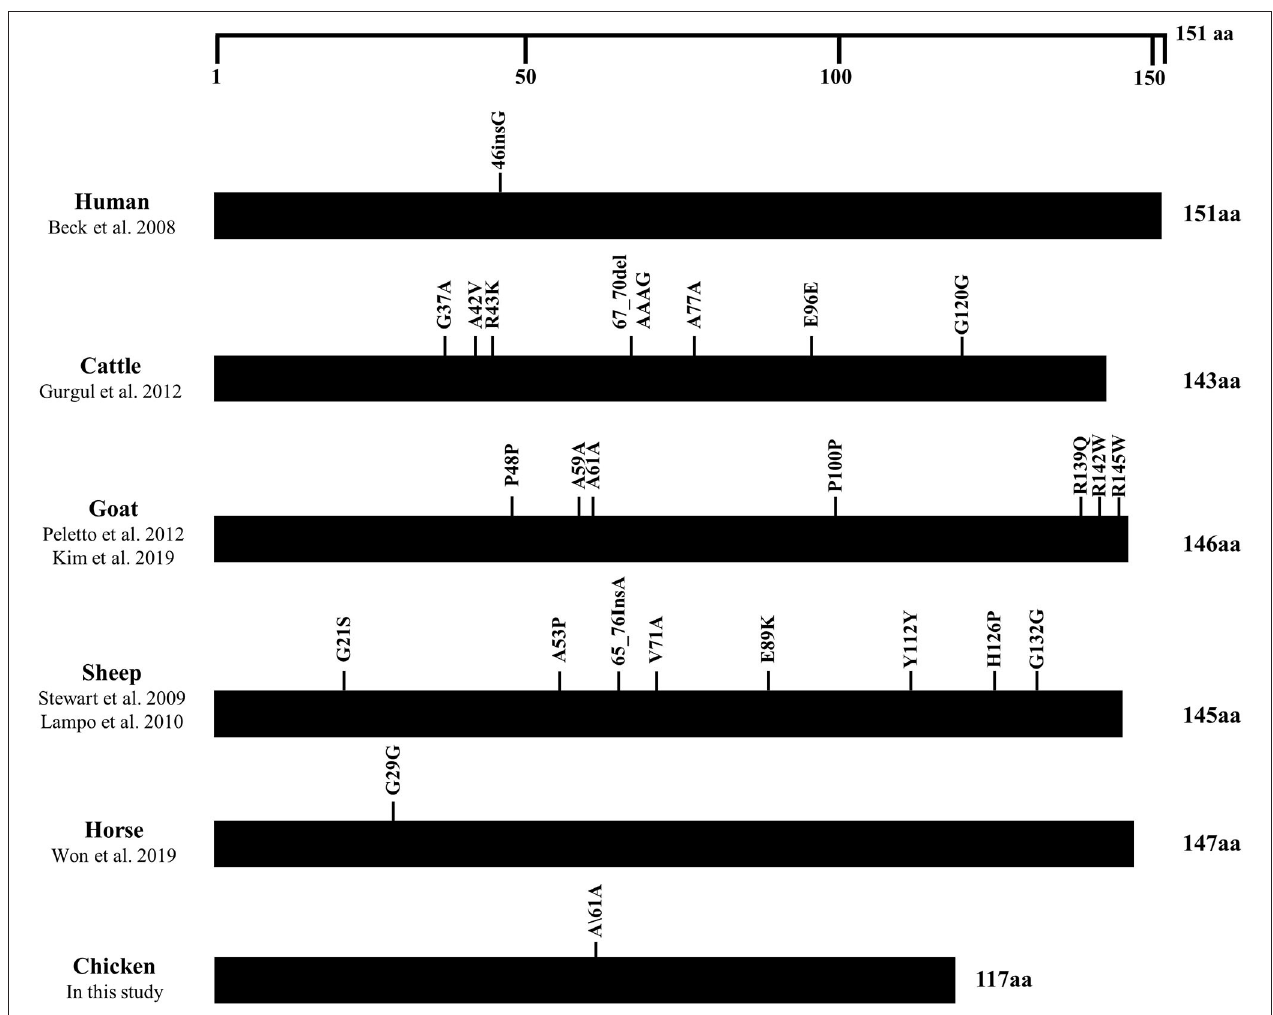
FIGURE 4 | Distribution of genetic polymorphisms in the open reading frame (ORF) of the SPRN gene in various species. The figure shows the previously reported genetic polymorphisms of the SPRN gene in humans, cattle, goats, sheep, horses and chickens. The edged horizontal bar indicates the length of the amino acids in the SPRN